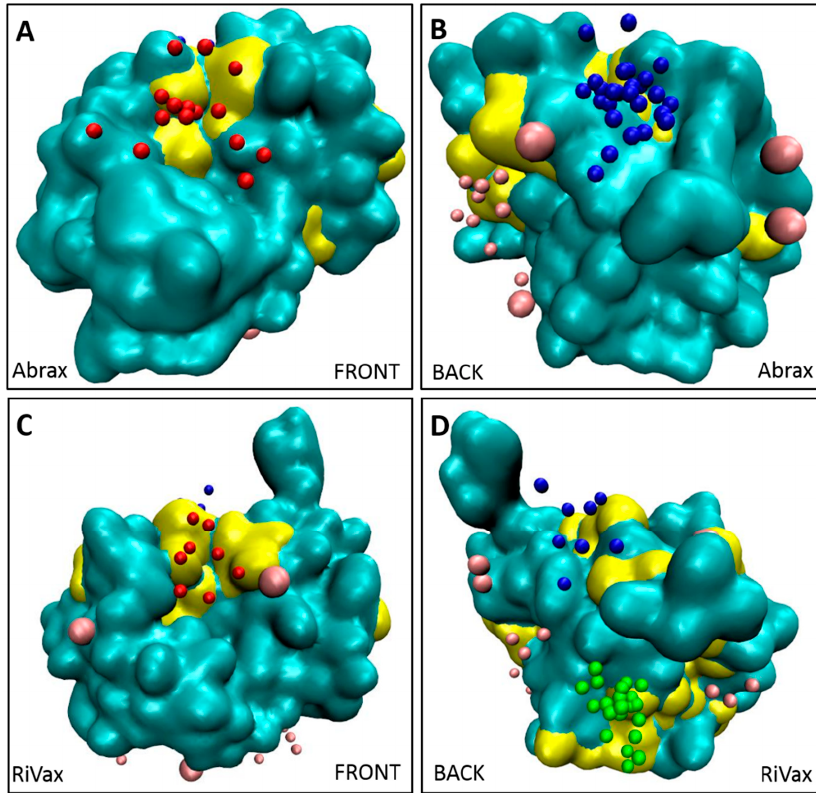
Figure 6. Clusters of hydrophobic residues from the Kyte-Doolittle scale (four or more in a row), colored in yellow, correspond to primary binding locations for both: abrax ( A , B ); and RiVax ( C , D ). Other residues of the protein are shown in cyan. Top 10 decoys for Tier 1 peptide binders (A5, A12, A14, and A15) are colored by location to show location 1 (blue), location 2 (red), location 3 (green) and other binding locations (pink). Front views of the proteins are shown in ( A , C ); and back views of proteins are shown in ( B , D ).